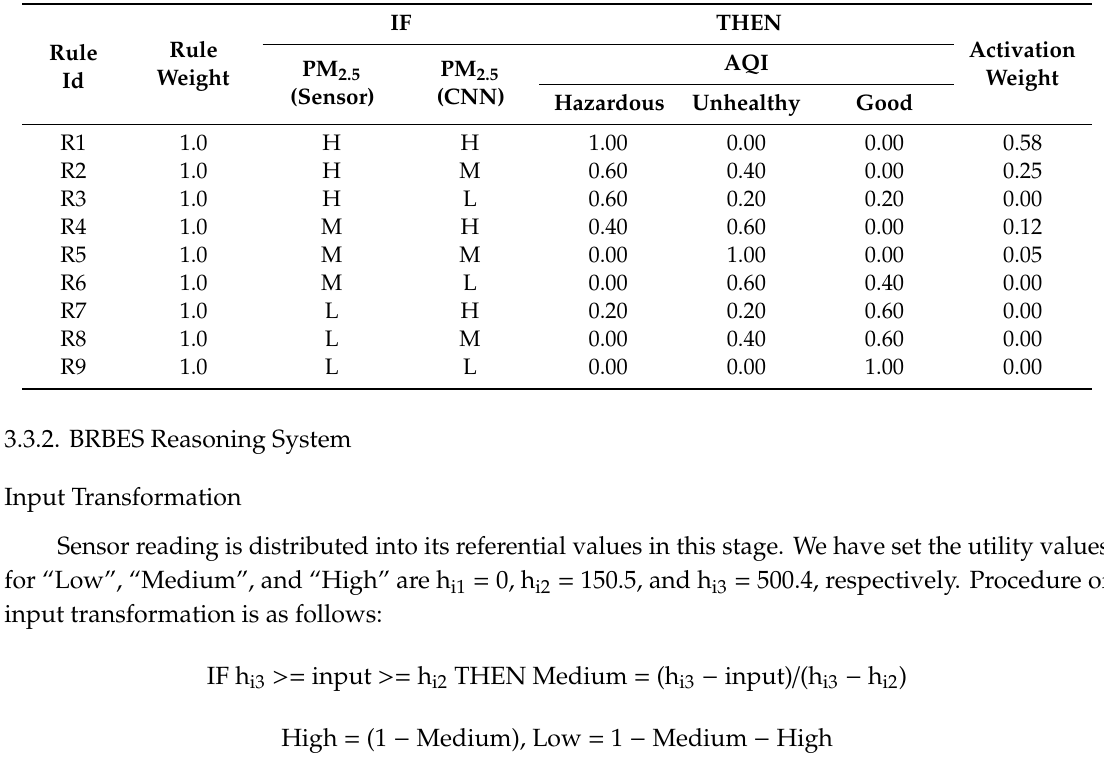
Table 3. Initial Rule